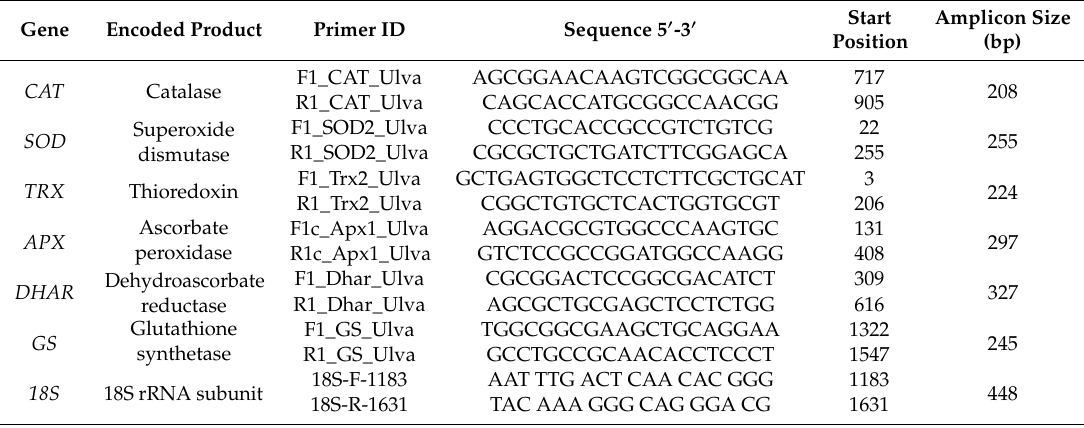
Table 1. Genes and primers for qPCR